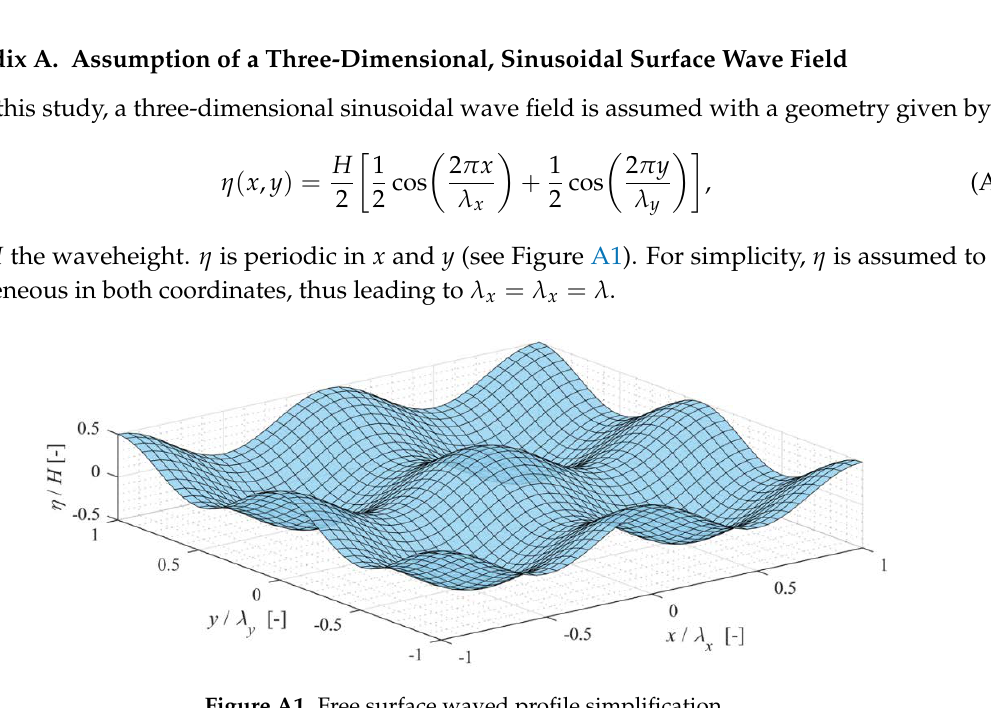
Figure A1. Free surface waved profile simplification.